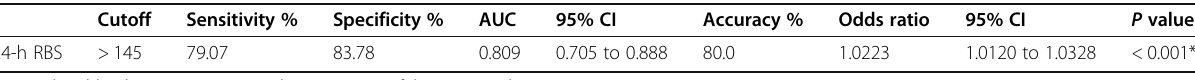
Table 4 Prognostic performance of 24 h random blood sugar levels for mortality prediction